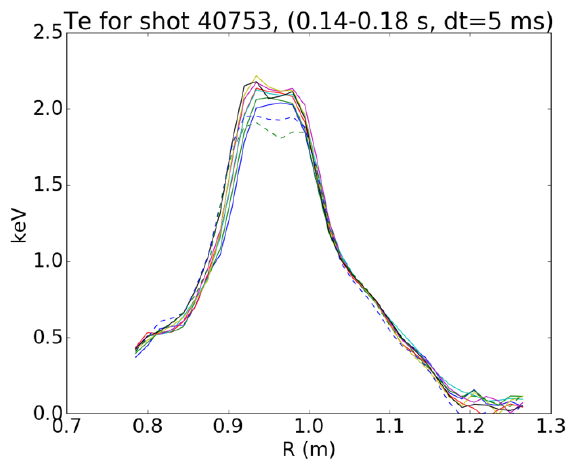
Fig. 12. Emissions below the probe frequency (shot